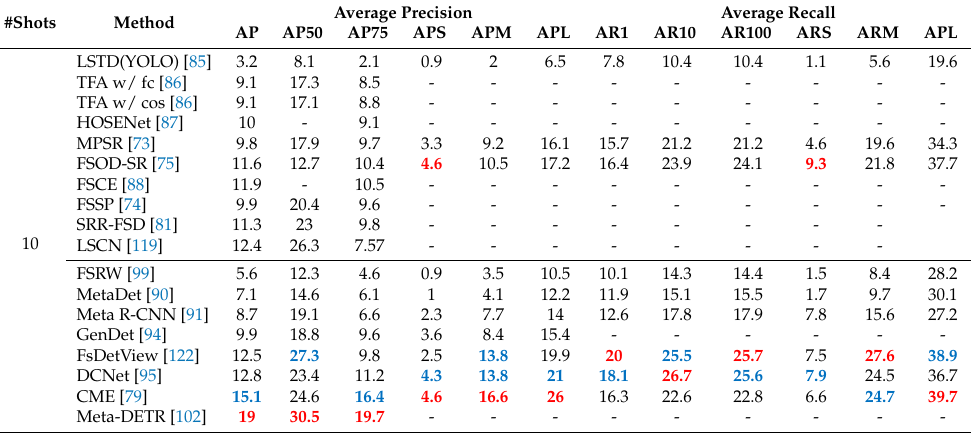
Table A3. Few-shot detection performance (AP (%) and AR (%)) of novel classes on the COCO dataset when 10-shot . Red, and blue indicate the state-of-the-art and the second-best, respectively.